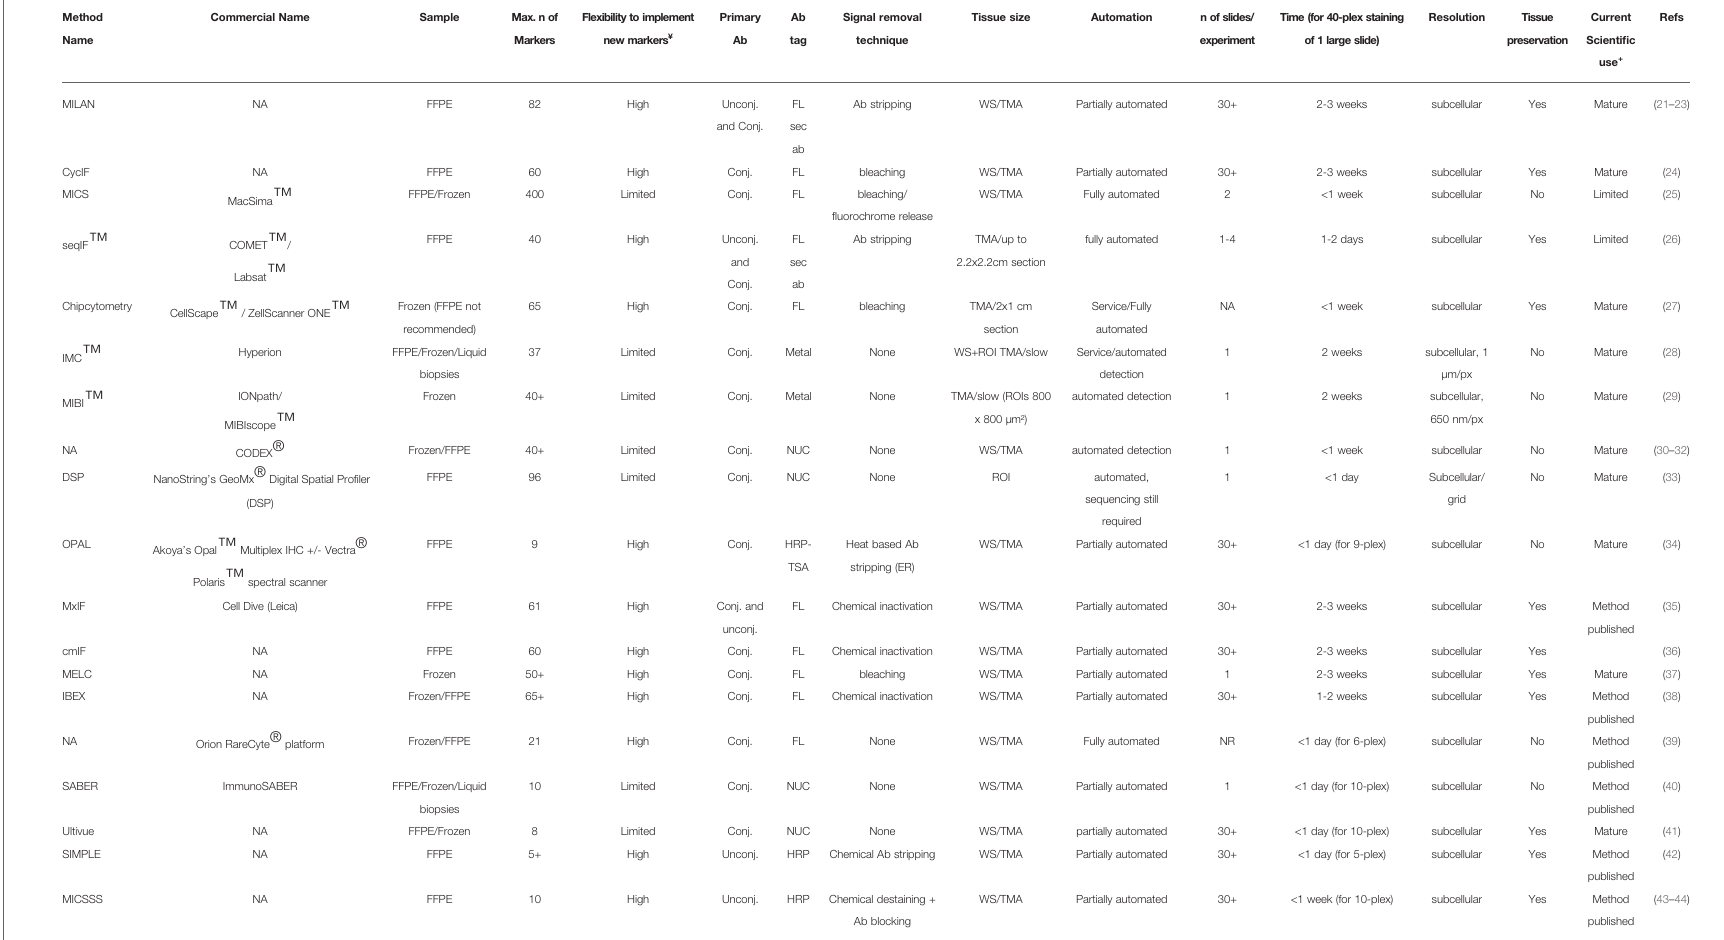
TABLE 1 | Technical overview of multiplex IHC staining